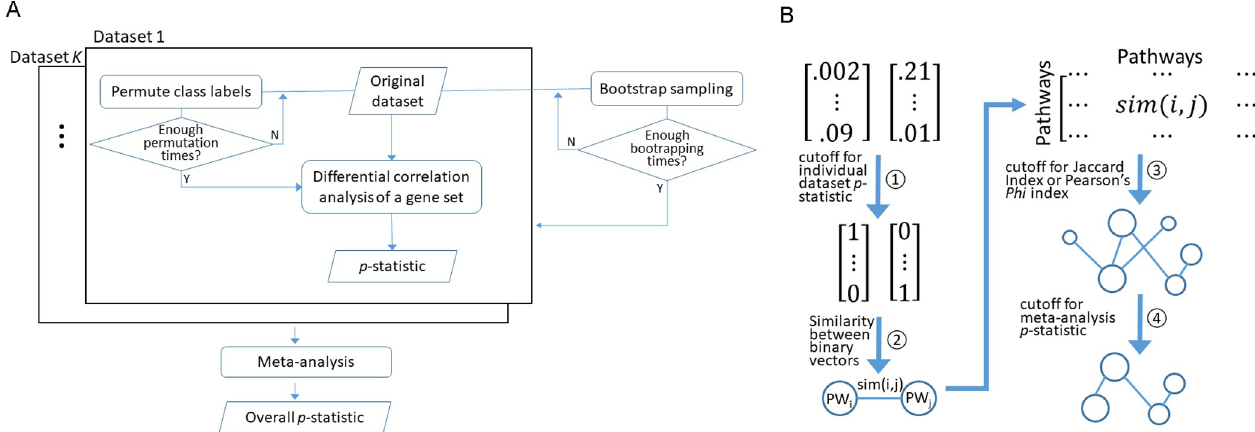
Fig 1. MetaGSCA schema. A) Meta-analysis of gene set differential coexpression. The kernel algorithm is based on the GSNCA method and yields a p -statistic for each individual study or dataset. MetaGSCA wraps a meta-analysis framework around the kernel algorithm to estimate an overall effect over individual studies and constructs nonparametric confidence intervals via bootstrapping. B) Pathway crosstalk analysis is performed as an optional step following the meta-analysis. In the schematic network, node size is proportional to the overall p -statistic estimated in the meta-analysis; a threshold of significance is applied to filter non-significant pathways. PW i : the i th pathway; PW j : the j th